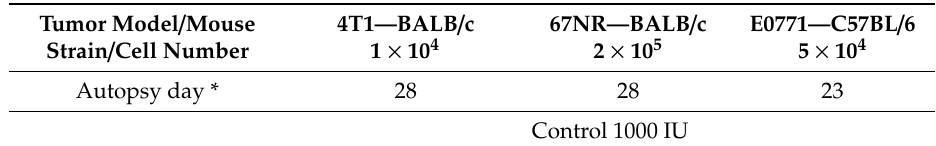
Figure 1. Time-course of experiments conducted in BALB / c and C57BL / 6 tumor-bearing mice. Euthanasia and the last blood collection in the case of C57BL / 6 mice were performed on day 23. Table 1. Summary of experiments performed on